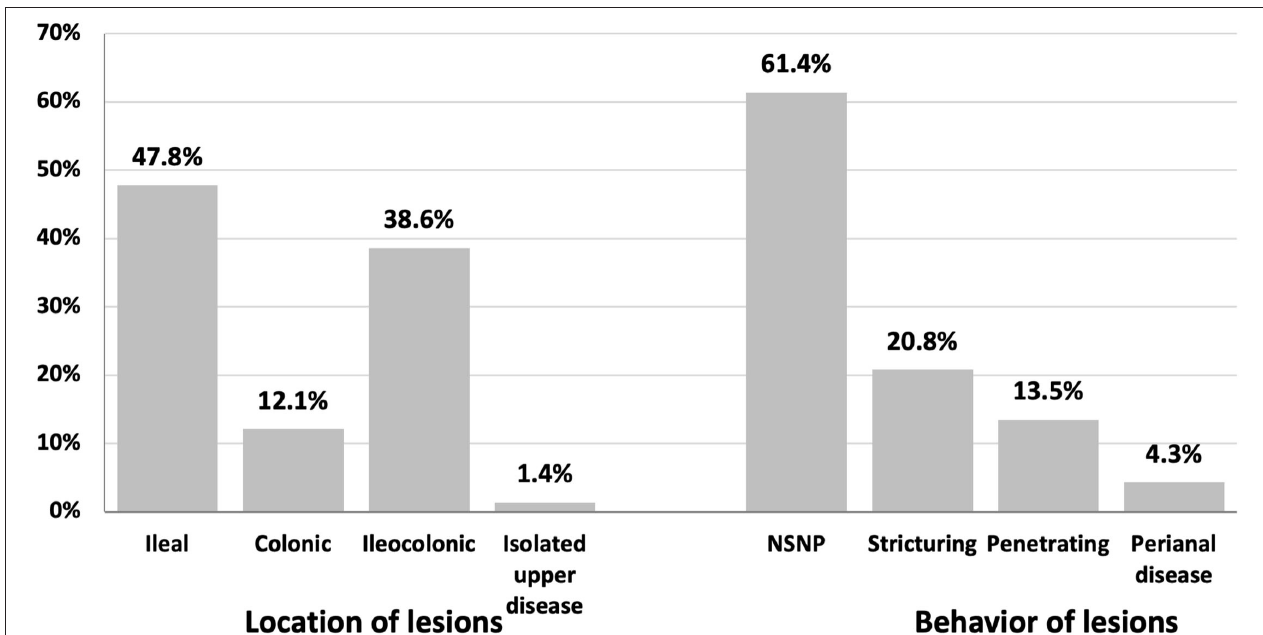
FIGURE 2 | Location and behavior of lesions by colonoscopy in patients with Crohn’s disease in Egypt (May 2018 to August 2021) at the time of diagnosis.